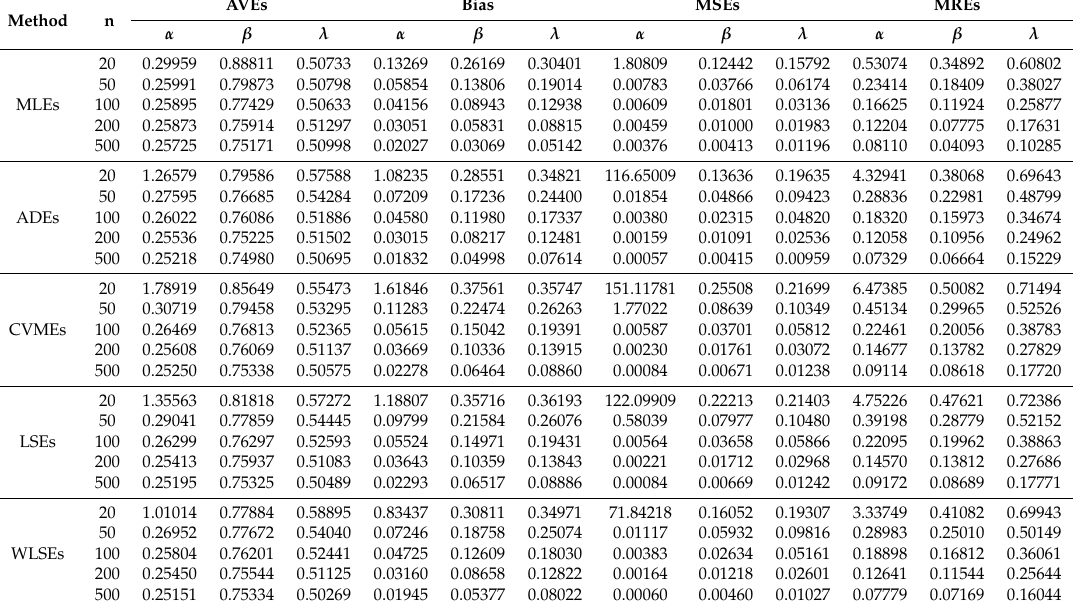
Table 1. Simulation values of the averages (AVEs), biases, MSEs, and mean relative estimates (MREs) for ( α = 0.25, β = 0.75, λ = 0.5 ) . ADEs, Anderson–Darling estimators; CVMEs, Cramér–von Mises estimators; WLSEs, weighted least-squares estimators.